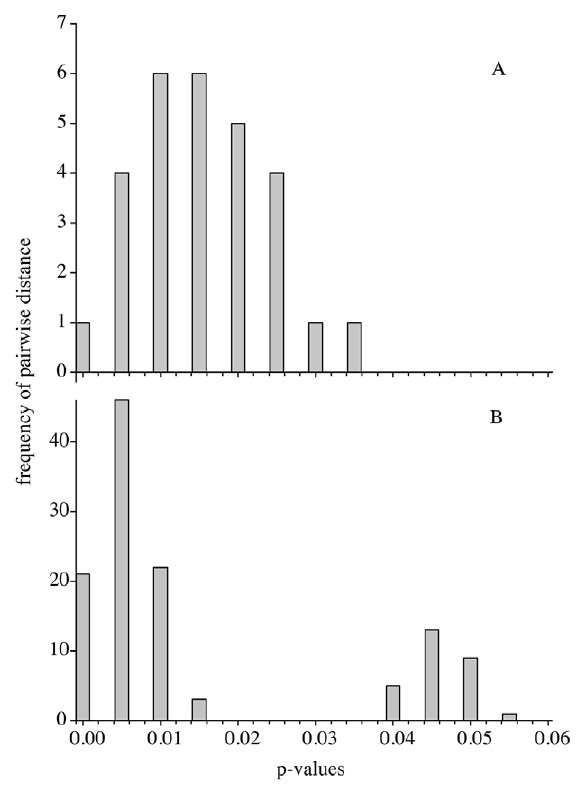
Fig. 3. – Frequency spectrum of pairwise genetic distances (p- distance) of 16S rRNA gene among specimens of the cumacean subgenus Crymoleucon Watling, 1991. A, L. intermedius Mühlen- hardt-Siegel 1996. B, L. antarcticus Zimmer 1907. On the right side of the graph: distances between specimens of the Weddell Sea and the Ross Sea. On the left side of the graph: distances between speci- mens from within the Weddell Sea or the Ross Sea,